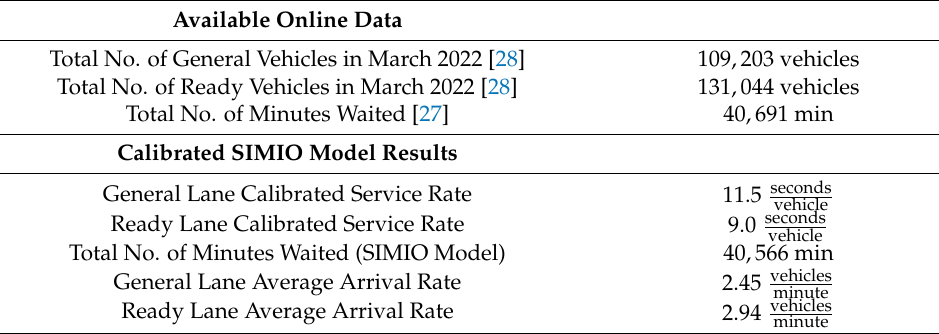
Table 1. Summary of the calibration values. Available Online